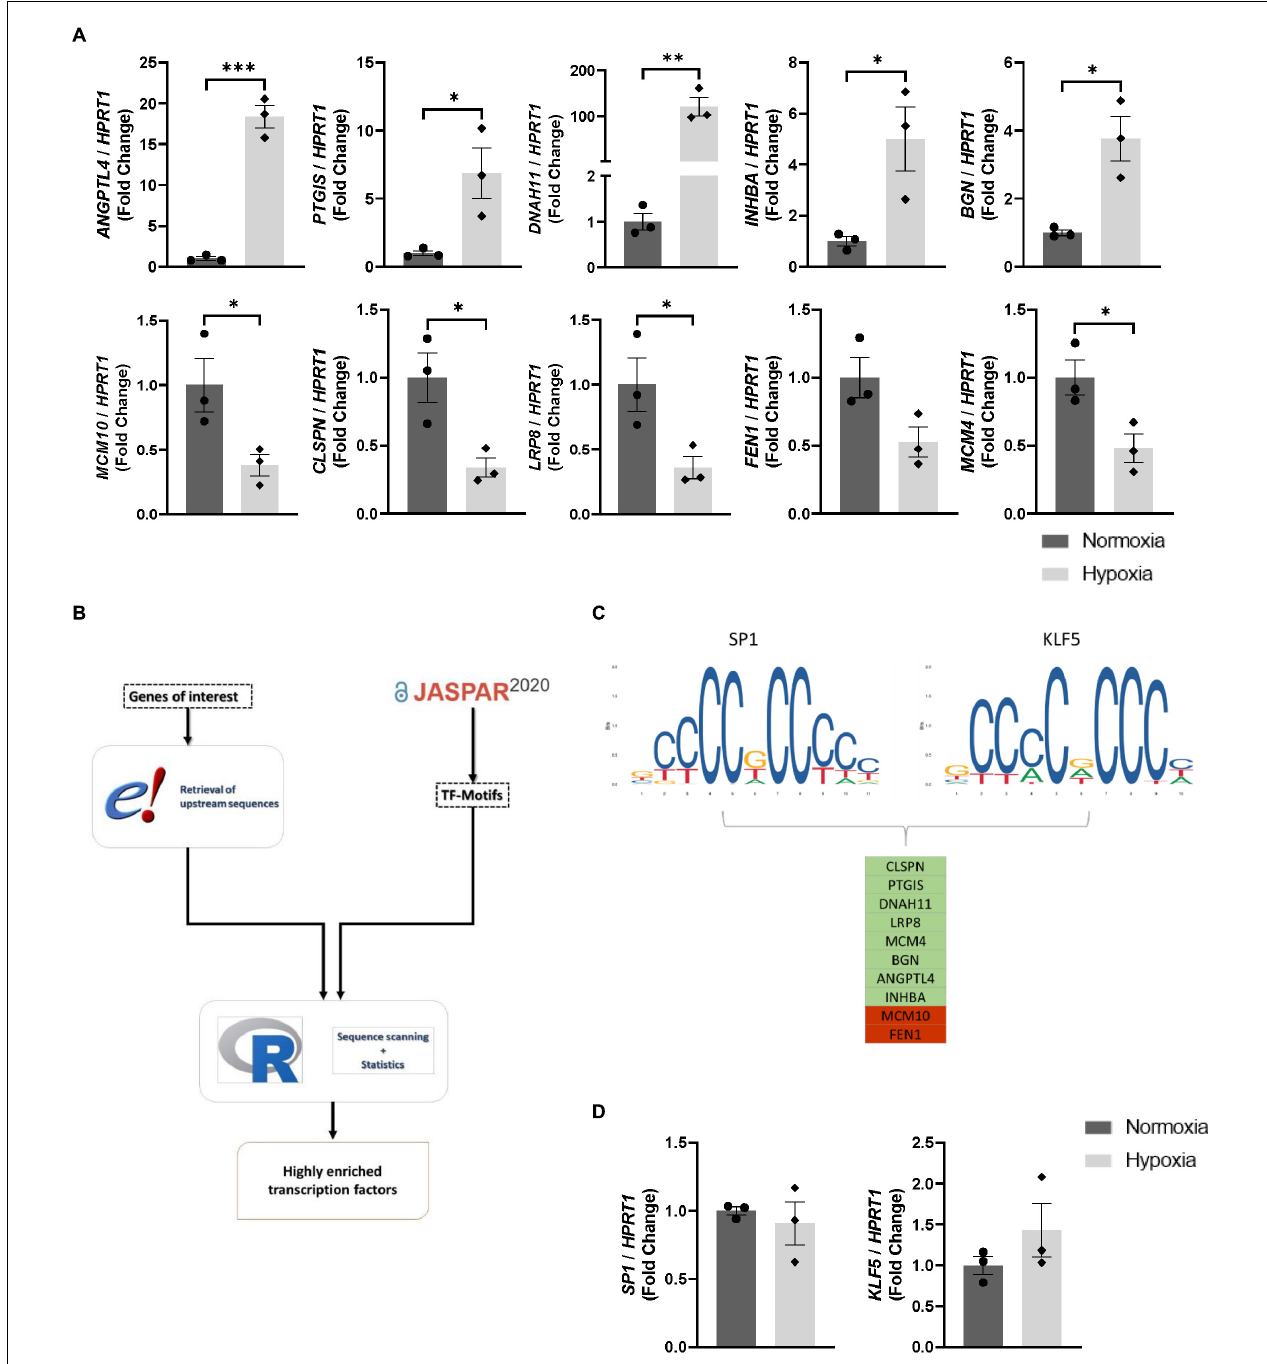
FIGURE 1 | Transcription factors SP1 and KLF5 are potential regulators of EC transcriptional response to hypoxia. (A) mRNA levels of selected genes from a previously reported RNA-Seq dataset were validated in HUVECs after 24 h of hypoxia via qPCR ( n = 3). (B) Bioinformatic pipeline for the selection of transcription factors. (C) In silico prediction of potential binding sites for SP1 and KLF5 in hypoxia-sensitive geneset. (D) qPCR data of SP1 and KLF5 mRNA levels in HUVECs after 24 h of hypoxia ( n = 3). Each dot resembles the mean value of all technical replicates from an independent experiment. ∗ p ≤ 0.05, ∗∗ p ≤ 0.01, ∗∗∗ p ≤ 0.001.